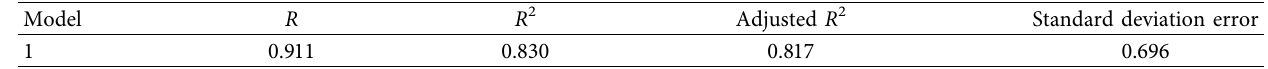
Table 8: BP neural network predicted value fit.